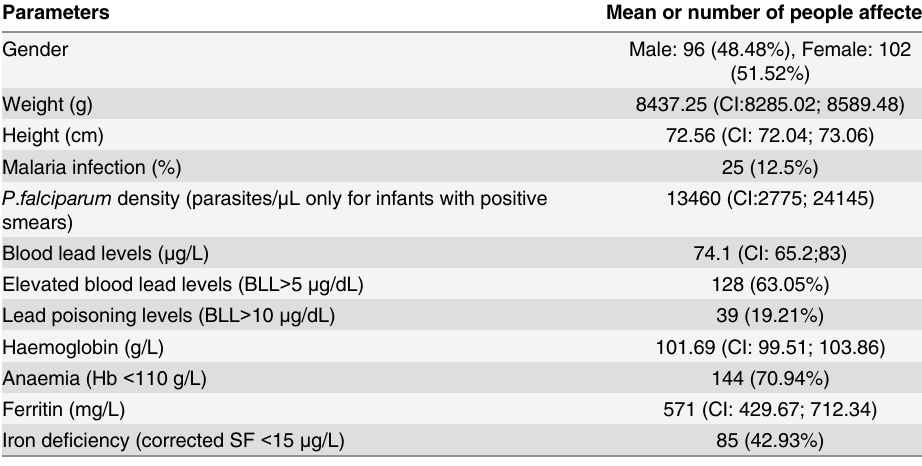
Table 1. Demographic and clinical characteristics of the